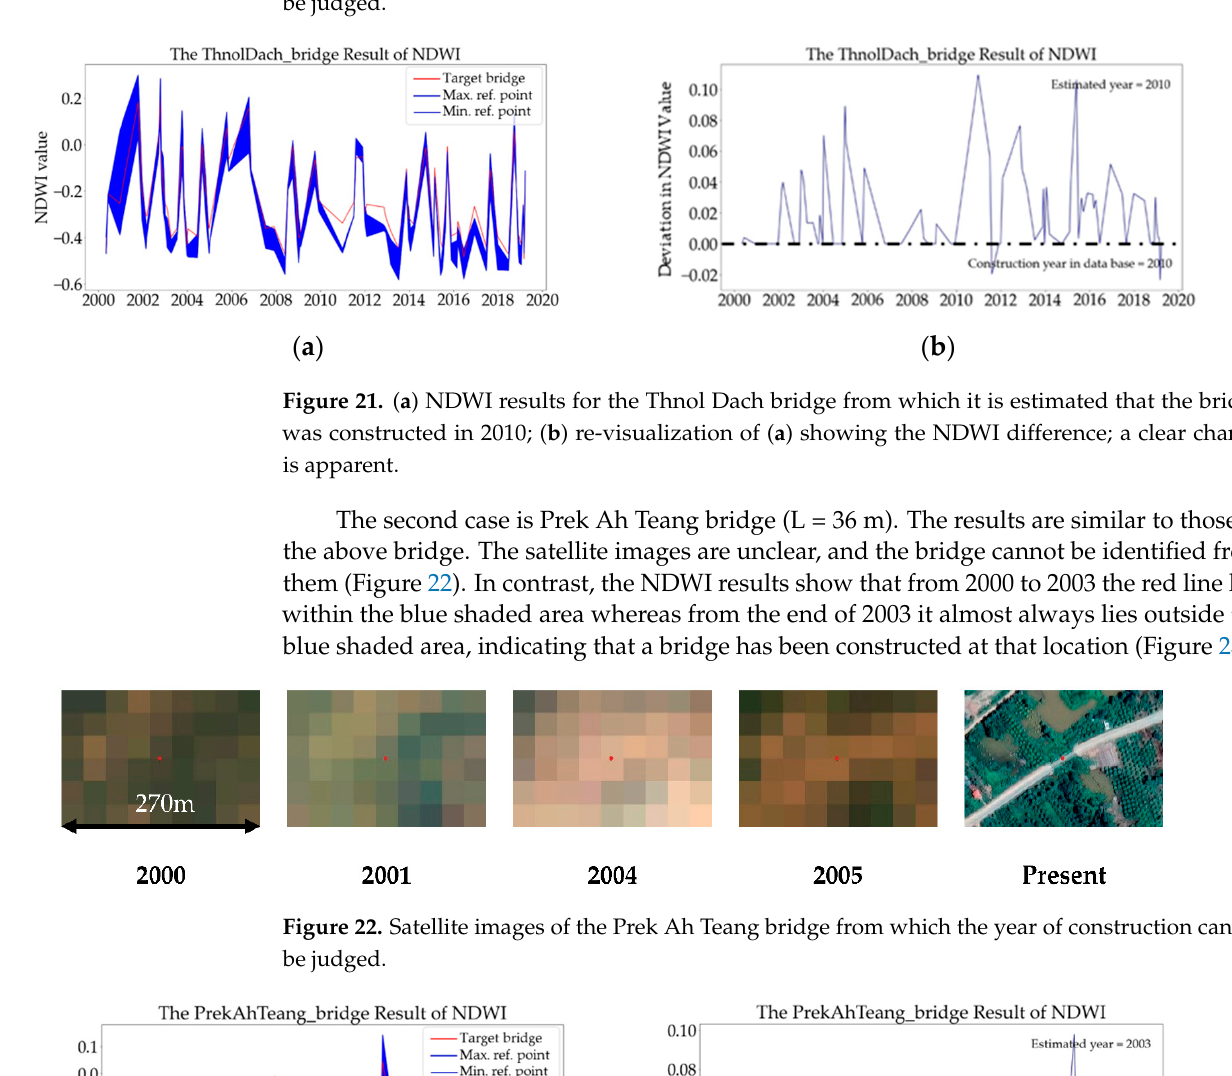
Figure 20. Satellite images of the Thnol Dach bridge from which the year of construction cannot be judged.